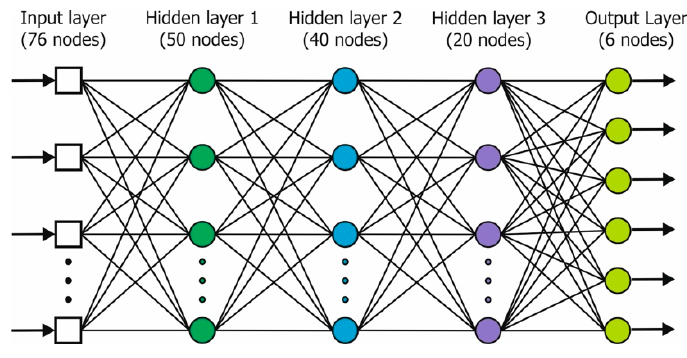
Figure 8. Selected ANN Topology (76-50-40-20-6).